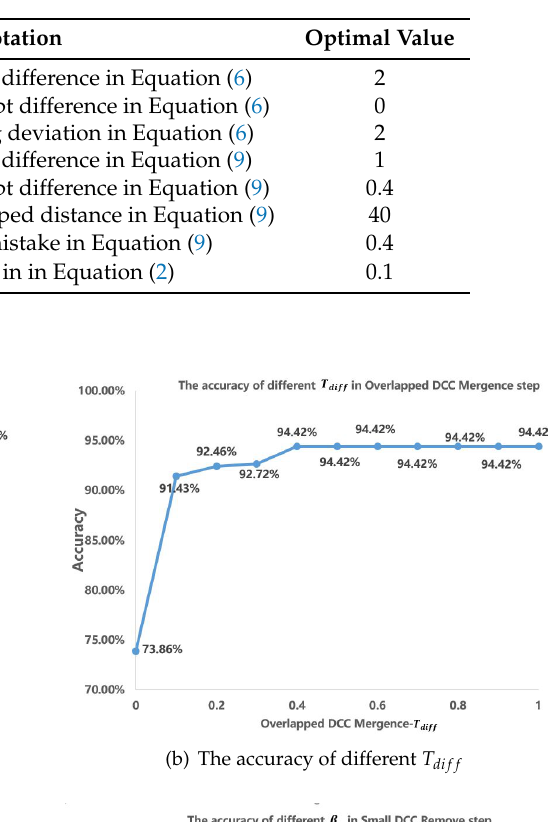
Table 6. Tested thresholds.